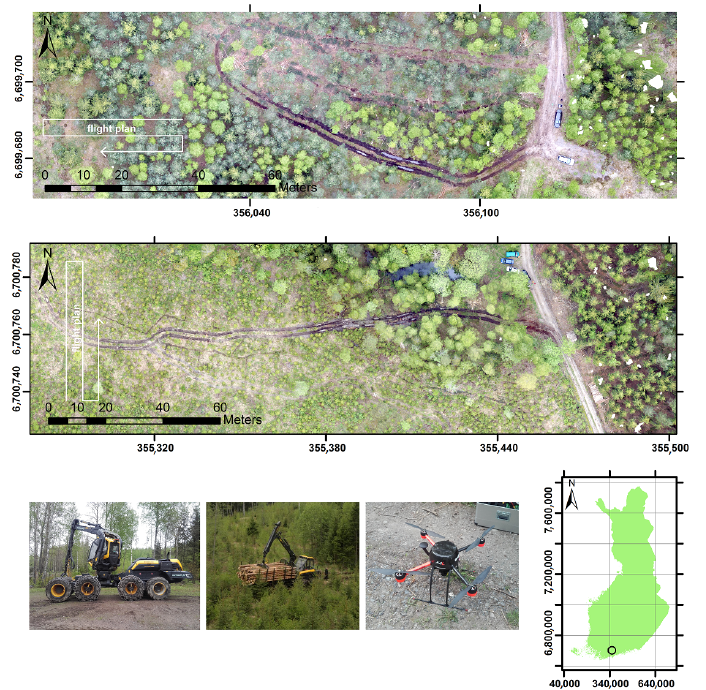
Figure 1. Top and middle : Trail 1 and Trail 2 areas as orthophotos and the drone flight plan schematics; bottom : the harvester, forwarder and drone used in the field campaign are shown with the map location (with the ETRS-TM35FIN coordinate system, see Abbreviations section) of the